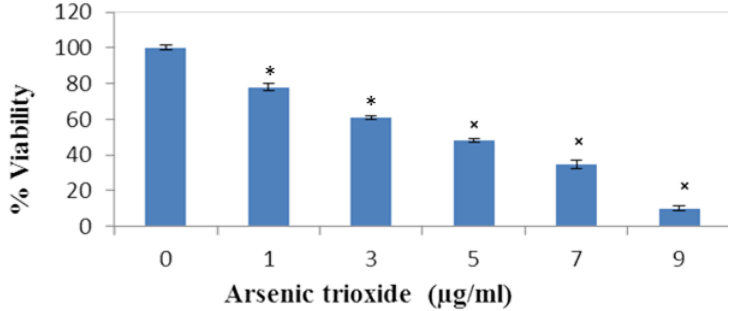
Figure 2. Cell viability of ATO-treated IPS after 24 hour exposure. IPS were treated for treated for 24 hours with ATO (0, 1, 3, 5, 7 and 9 µg/mL). Results showed a dose dependent decrease in cell viability with the a LD value being ~4.5 μg/mL. Each value 50 represents the mean ± standard error of three experiments performed in triplicate. Student’s paired t-test was used to analyze the difference between the control and ATO-treated cells. All p -values <0.05 were considered to be significant denoted by *.